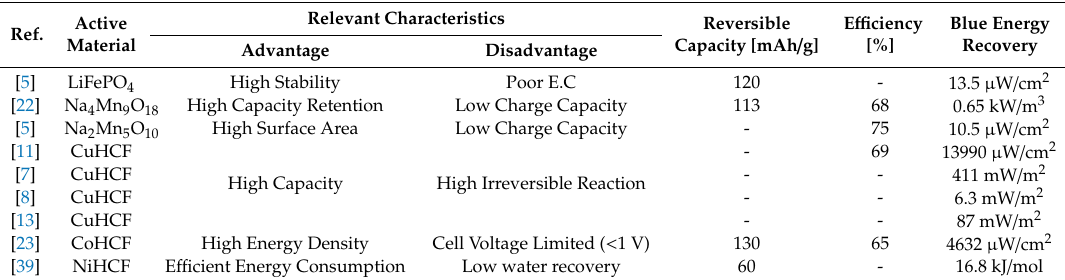
Table 5. Blue energy recovery using di ff erent cathode